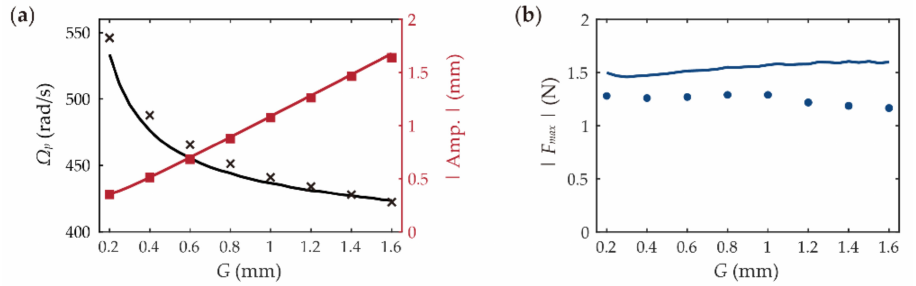
Figure 12. Experimental and modelling results of the effects of the constraint gap on ( a ) the peak frequency and oscillation amplitude and ( b ) the peak impact force. The discrete markers indicate experimental data, while the continuous curves are the modelling results.